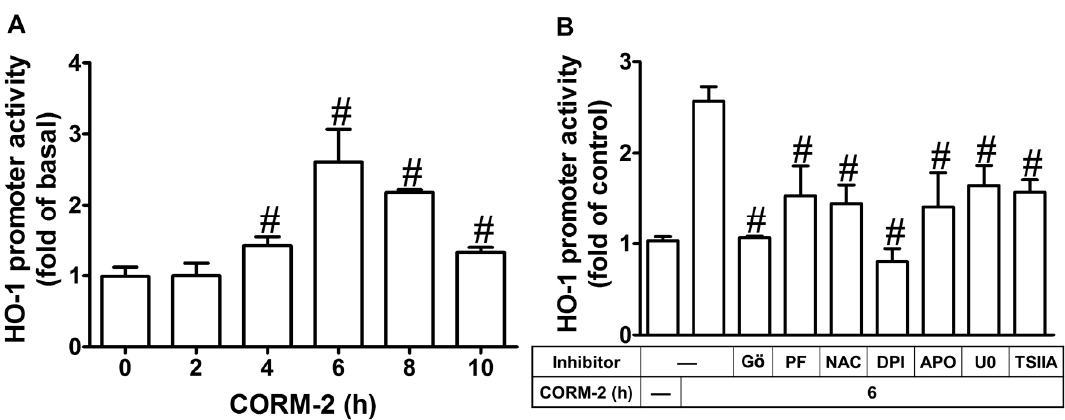
Figure 8. CORM-2 induces AP-1-dependent HO-1 expression via PKC α / Pyk2 / Nox / ROS / ERK pathway in HTSMCs. ( A ) Cells were transiently cotransfected with pHO1-Luc and pGal for 24 h, and then incubated with CORM-2 (50 µ M) for the indicated time intervals. ( B ) Cells were pretreated with Gö6983 (10 μ M), PF431396 (10 μ M), NAC (10 mM), DPI (10 μ M), APO (100 μ M), U0126 (10 μ M), or TSIIA (10 μ M) for 1 h and then incubated with CORM-2 for 6 h. The HO-1 promoter activity in the cell lysates was determined. Data are expressed as mean ± SEM of five independent experiments ( n = 5). # p < 0.05, as compared with the cells exposed to vehicle ( A ) or CORM-2 alone. Data analysis and